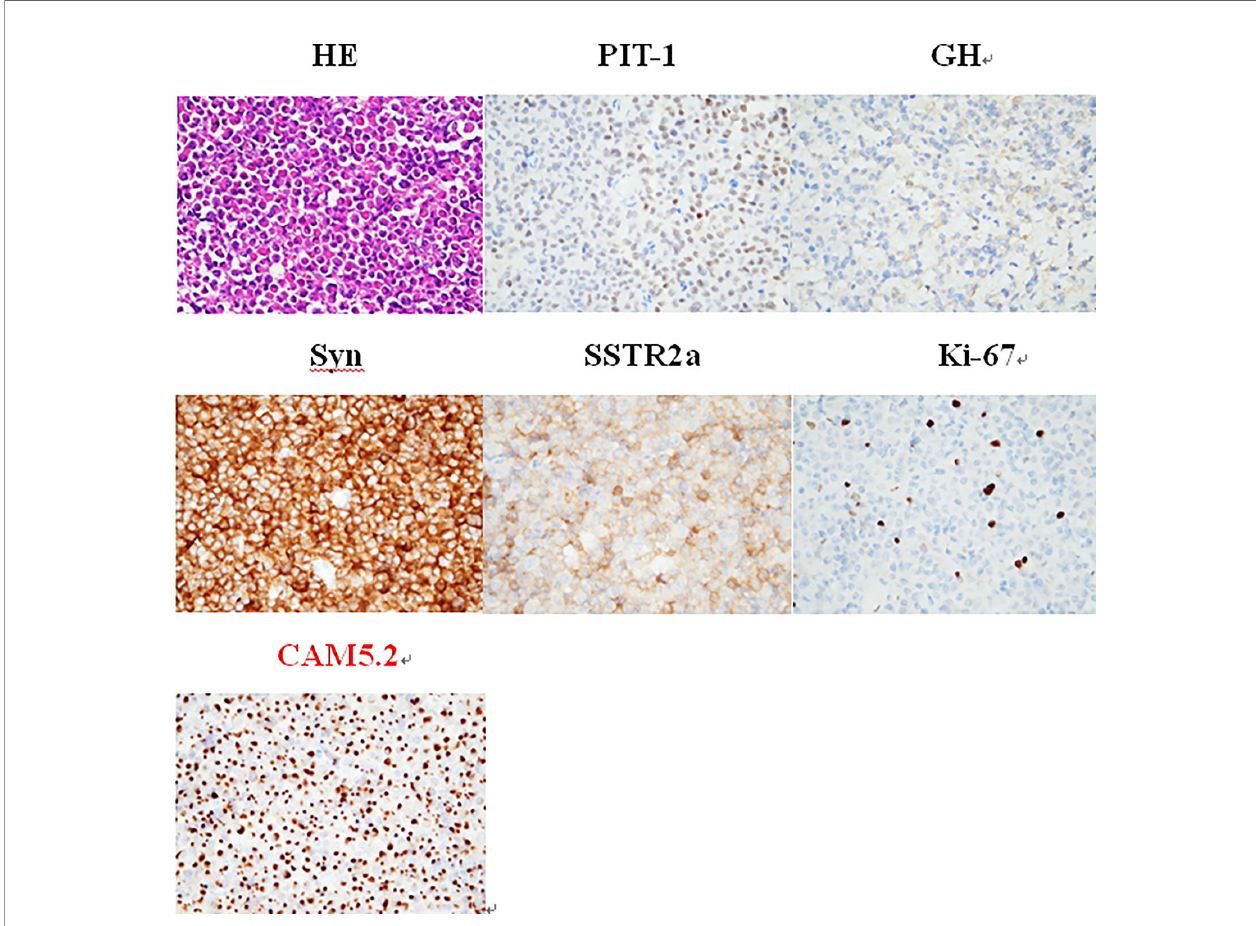
FIGURE 3 | The IHC is positive for PiT-1, whereas keratin (CAM 5.2) reveals the presence of fi brous bodies in the cytoplasm. Therefore, the diagnosis of a somatotroph carcinoma of sparsely granulated type was established. HE staining (×400): small round nucleus tumor cells in a lamellar nest-like arrangement with rich cytoplasm and nucleus eccentricity, nucleus atypia with visible mitosis; IHC staining (×400): PIT-1 (+), GH (+), Syn (+), SSTR2a (+), Ki-67 (8%), and CAM5.2